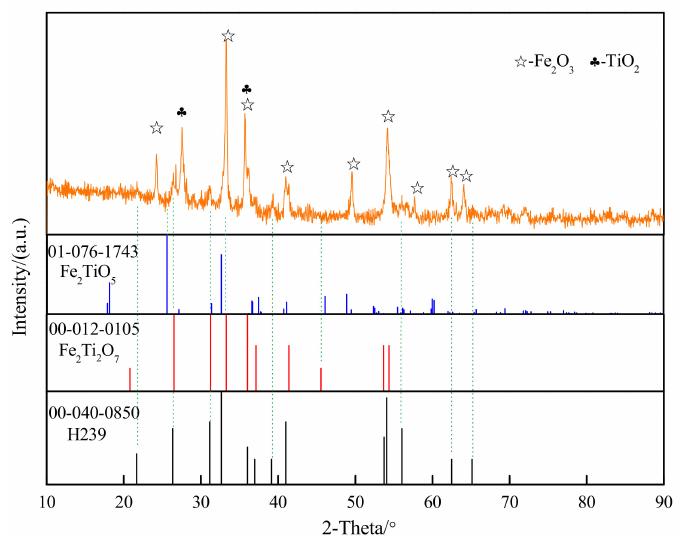
Figure 3. Confirmation of H239 and Fe 2 Ti 2 O 7 in oxidation